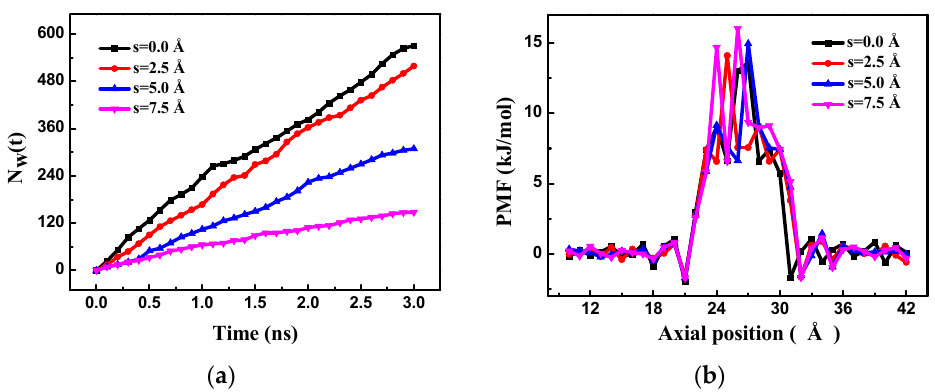
Figure 8. ( a ) The number of water molecules passing through the bilayer porous graphene membrane over time for different pore offsets; ( b ) the PMF of the bilayer graphene membranes for different pore offsets.